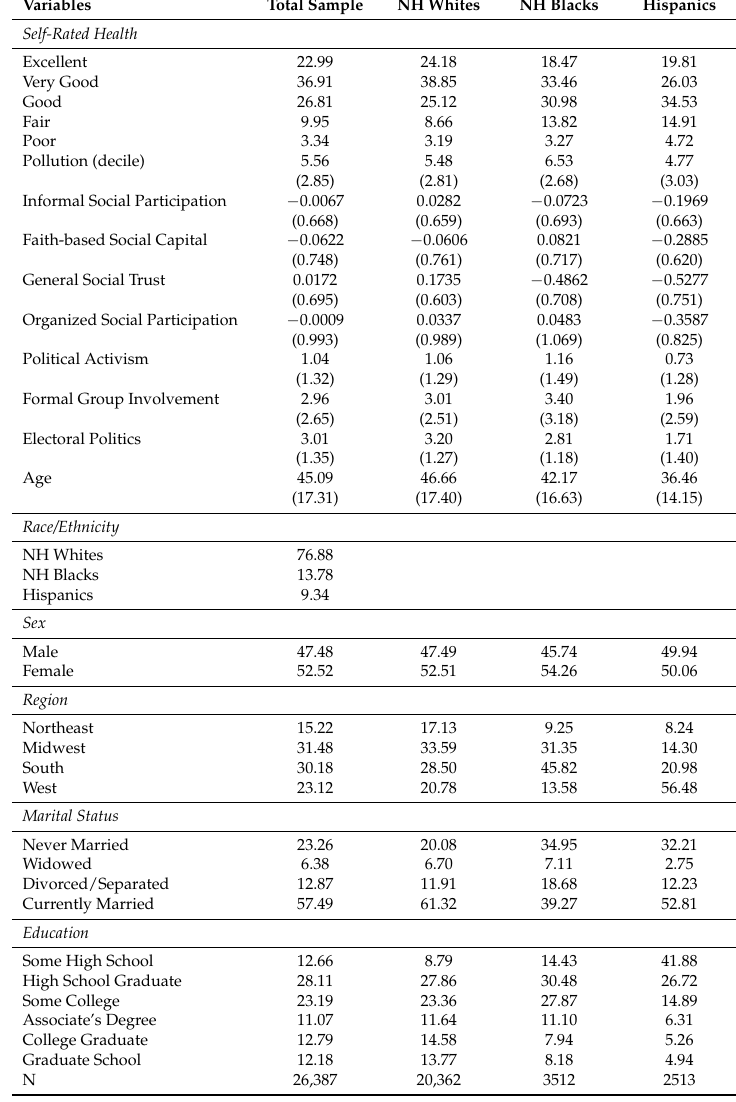
Table 2. Descriptive statistics on selected sociodemographic variables for all respondents and by race/ethnicity. Standard deviations are noted in